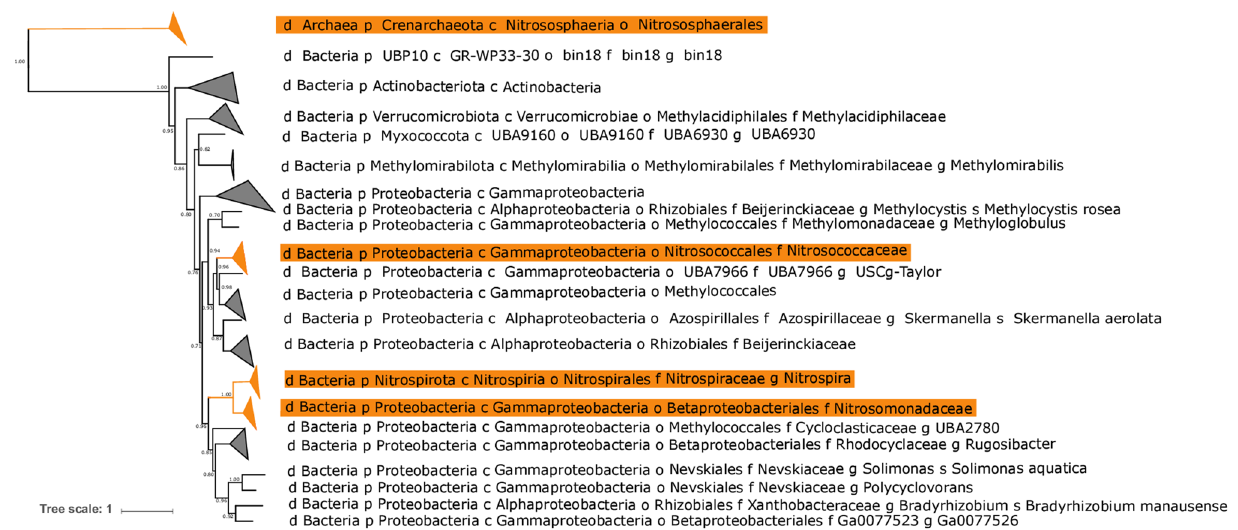
Figure 2. Phylogeny of concatenated protein sequences of CuMMO A and B subunits (i.e. AmoA and AmoB, PmoA and PmoB), with ammonia monoxygenases highlighted in orange. Major clades are collapsed and labeled by the taxonomy of the organisms in which they are found as determined with GTDB-Tk 16 . The